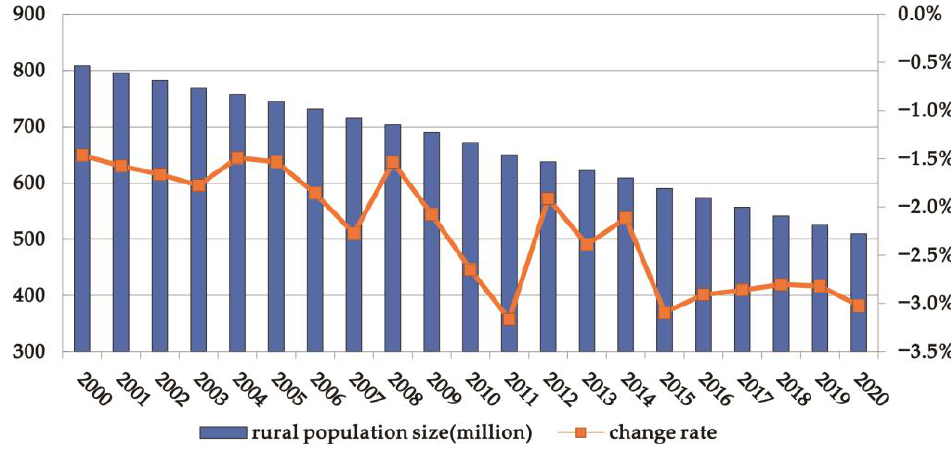
Figure 4. Rural population change at the national level from 2000 to 2020.